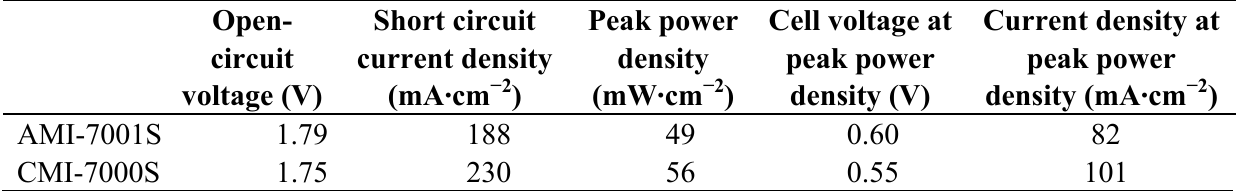
Table 2. Electrochemical parameters of the DBPFCs employing the studied membrane